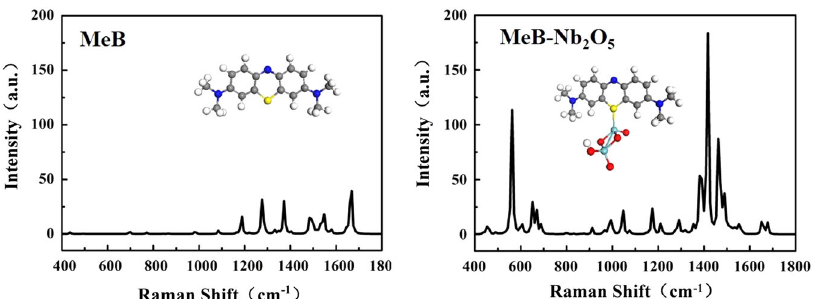
Fig. 3 Calculated Raman spectrum of a MeB, and b MeB-(Nb 2 O 5 ) 2 complex. The inset shows Optimized geometry of MeB, and MeB-(Nb 2 O 5 ) 2 complex, respectively